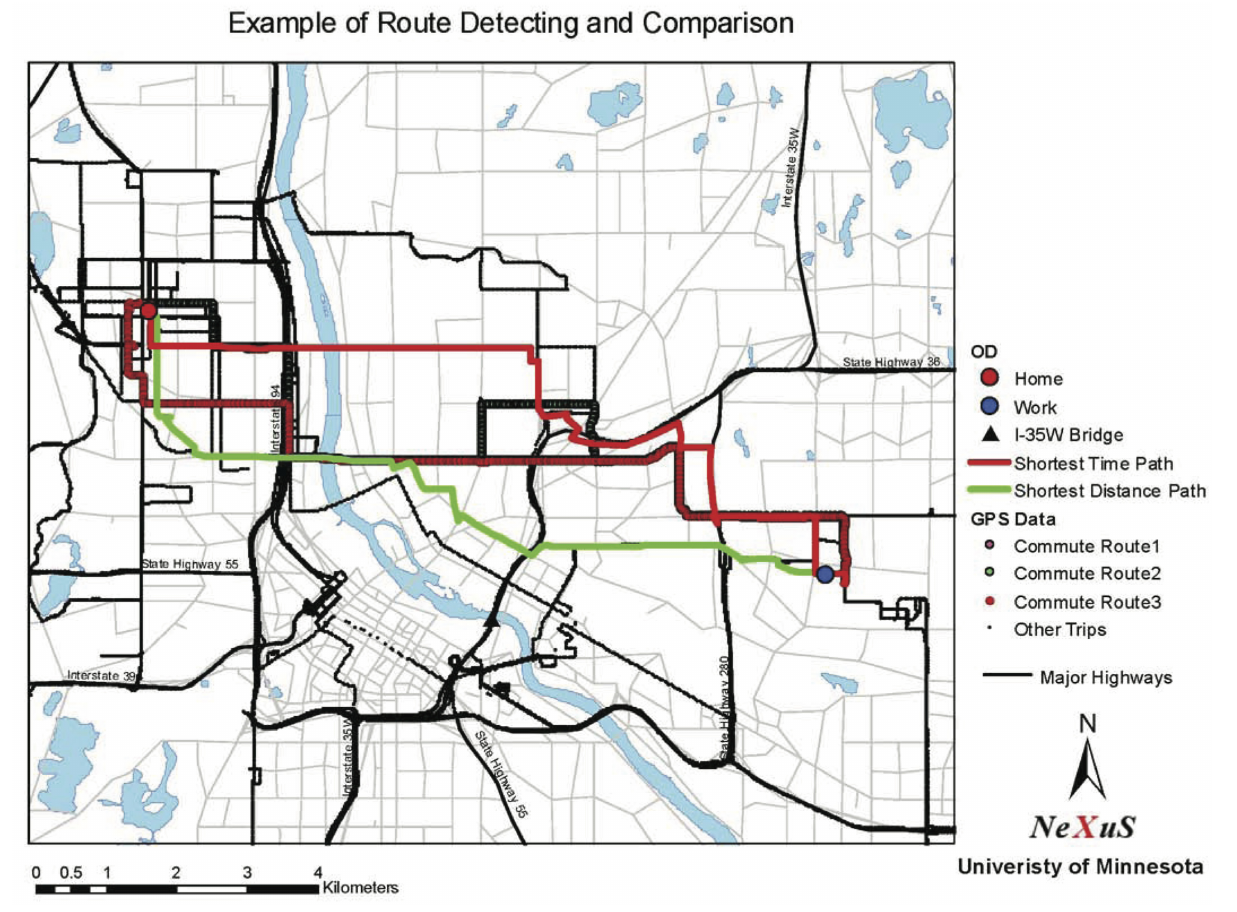
Fig 6. Example of commute route identification and